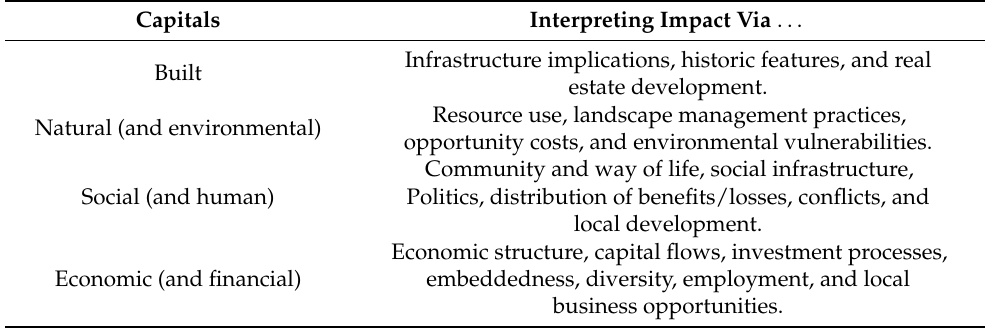
Table 1. Capitals, change variables, and their